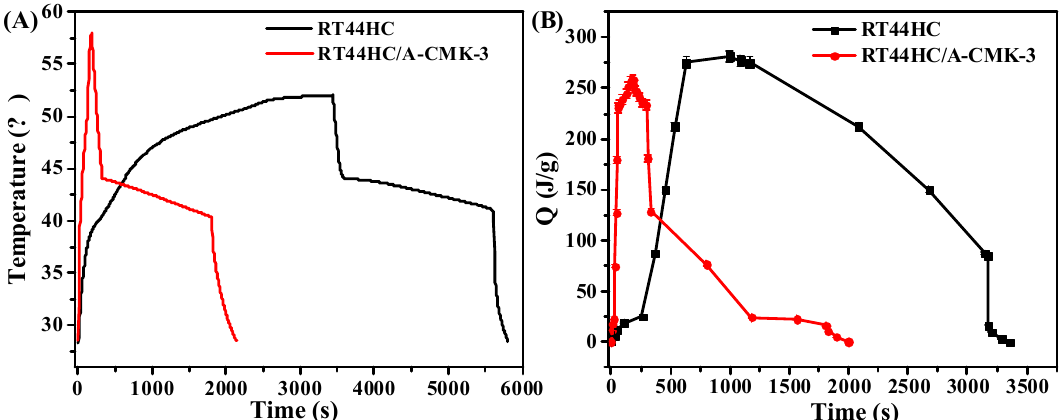
Figure 12. Photo-thermal performance of PCM ( A ), thermal energy charging and discharging behavior of PCM ( B ).